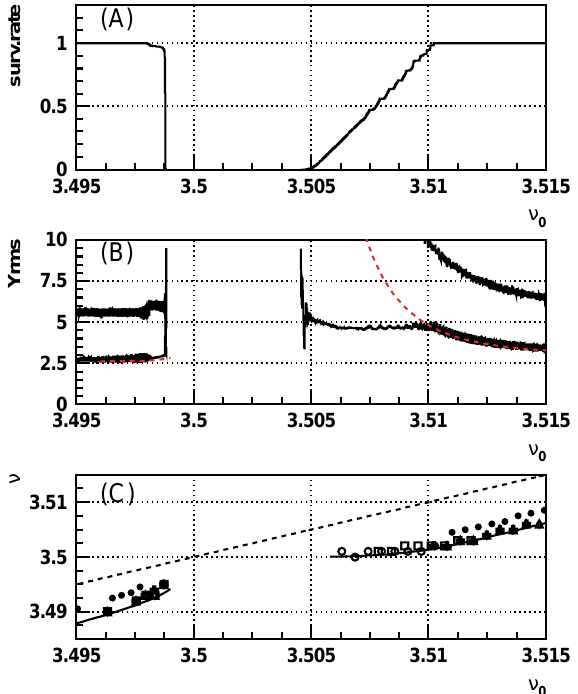
FIG. 9. (Color) Simulation results of resonance crossing, tak- ing account of the space-charge effect. The distributions of macroparticles are uniform. (A) Ratio of the survival macro- particles. (B) The rms (lower) and maximum (upper) beam sizes. The dashed line shows the matched solution of envelope equation. (C) Observed tunes: the solid circles show the half of the quadrupole mode coherent tune and the white characters show the tunes of five single particles, whose initial amplitudes are 1–2 times the rms beam size. The dashed line is an unper- turbed bare tune ( n 0 ). FIG. 10. (Color) Same as Fig. 9 but for a parabolic